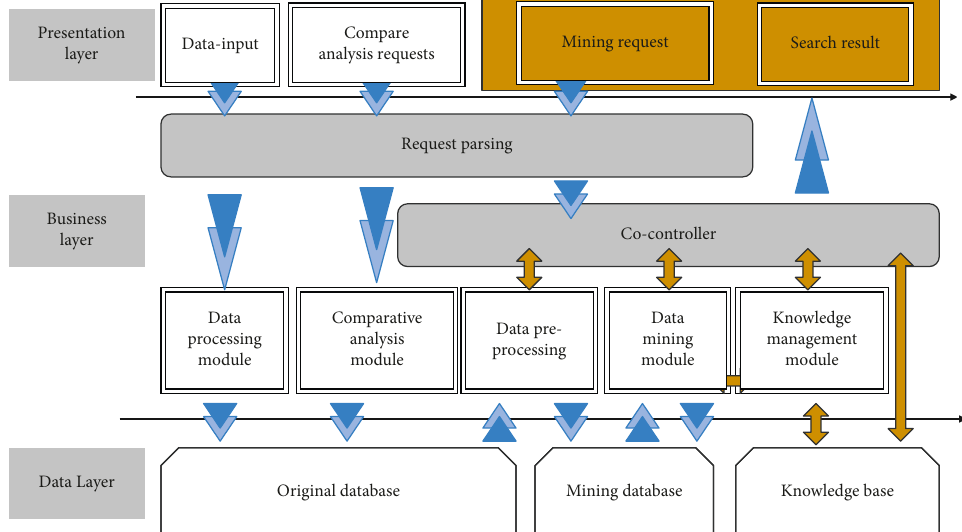
Figure 2: The three-layer structure of the international Chinese education expert system.